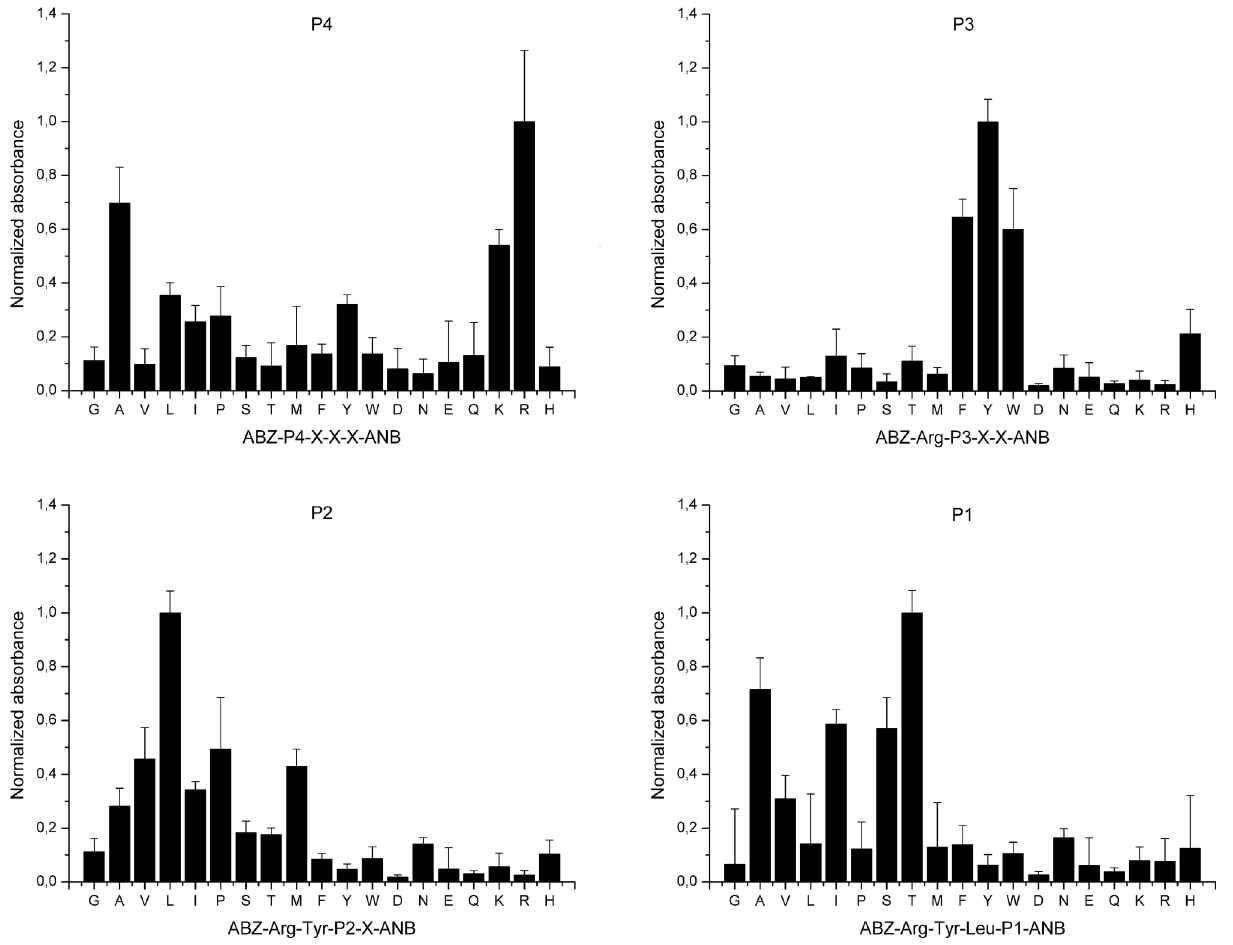
Figure 1. Substrate specificity of SplD at P4-P1 subsites. Substrate preference of SplD protease was determined using libraries of synthetic tetrapeptide substrates (LSTS). Libraries of a general structure ABZ-P4-P3-P2-P1-ANB-NH deconvoluted starting form P4 position as described in Materials and Methods. Vertical bars indicate the activity of the enzyme (absorbance of released ANB-NH ) against particular sub-libraries normalized to the most active sub-library in each library. 2 Residues fixed at particular subsites (designated at the top of each panel) are indicated with the single-letter amino acid code. X indicates randomized substrate